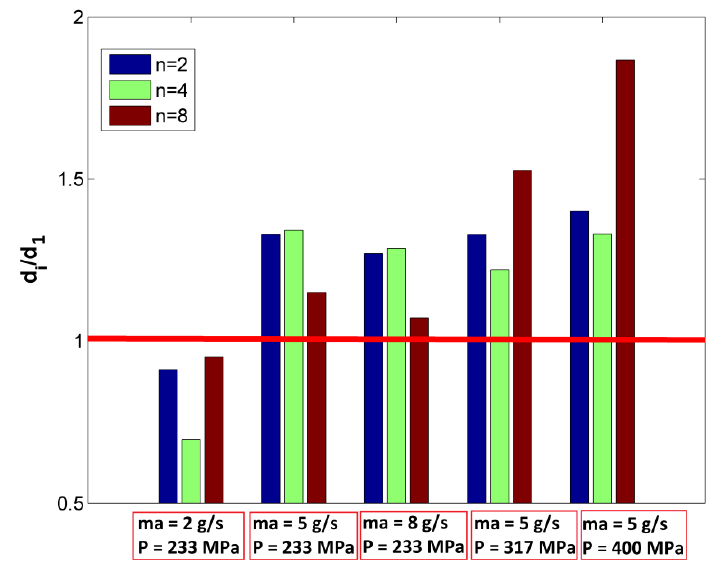
Figure 5. Ratio of total depth of penetration for multi-pass cases to depth of penetration achieved by a single pass under various process conditions.